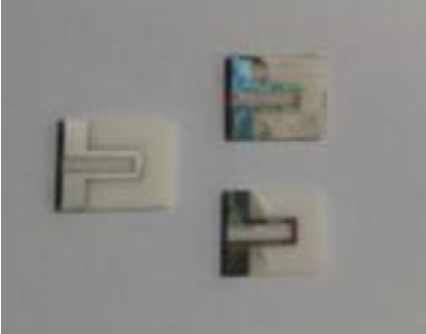
Figure 4. Tungsten–rhenium thermocouple after high temperature oxidation.